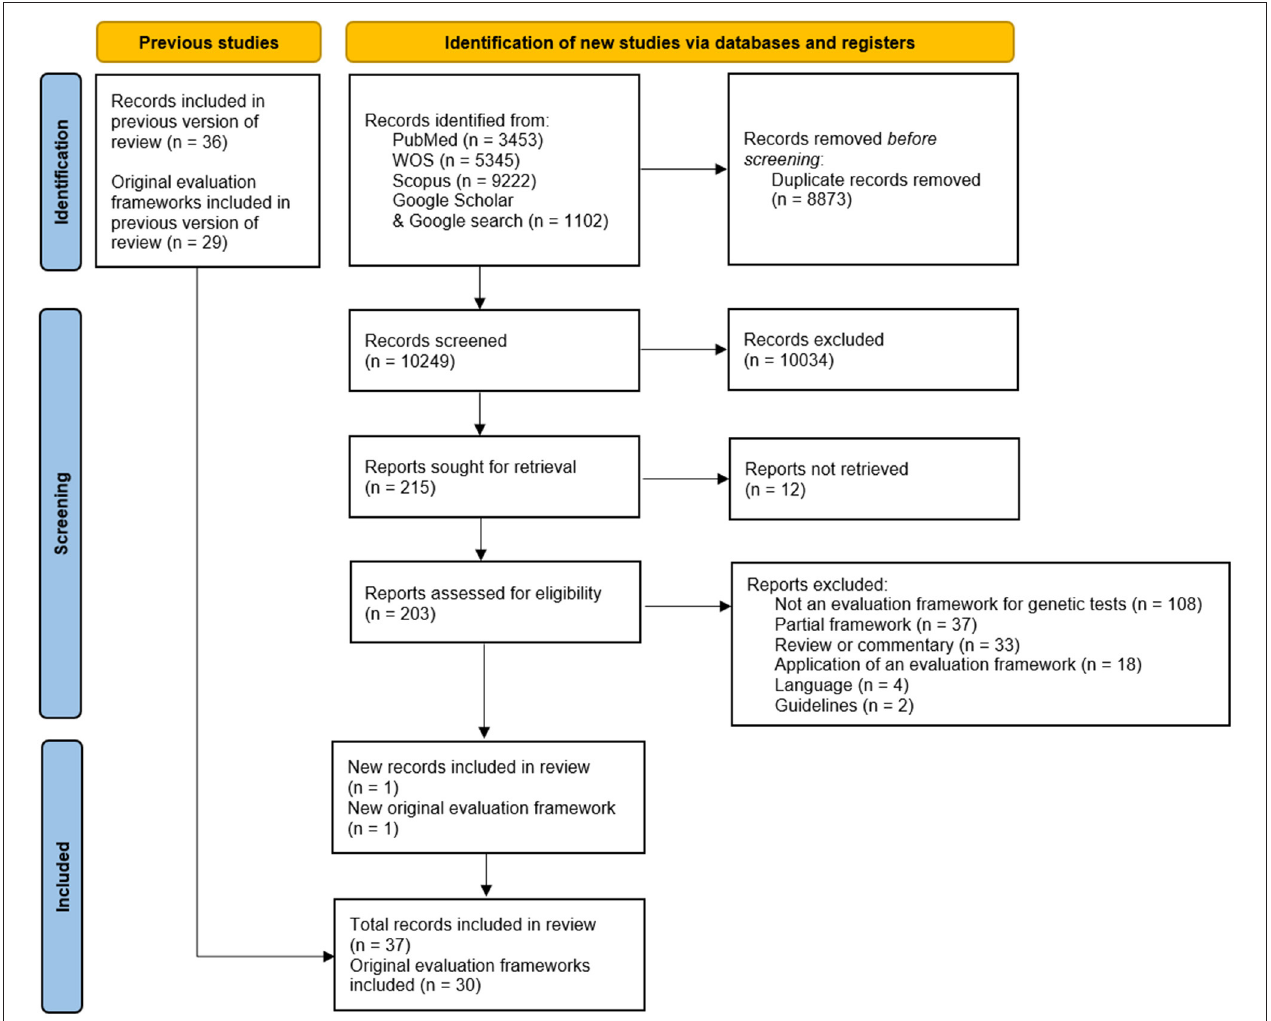
FIGURE 1 | PRISMA 2020 flow diagram for the 2021 update of our 2018 systematic